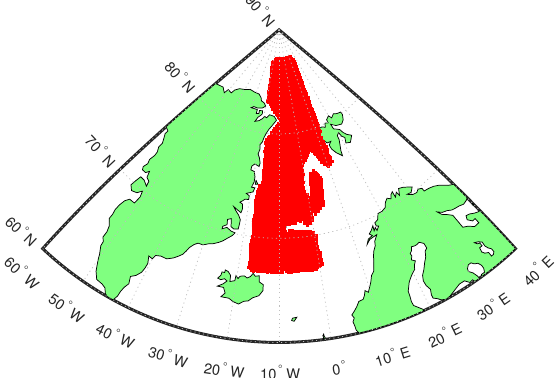
Figure 2. Map of the locations (red areas) of CS-2 waveforms used for the unsupervised classification model taken within the time period of April–May